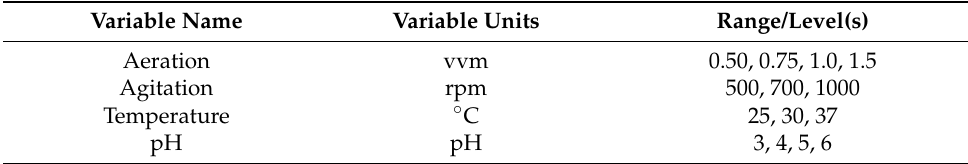
Table 2. Operational variables used for the study of the independent factors.